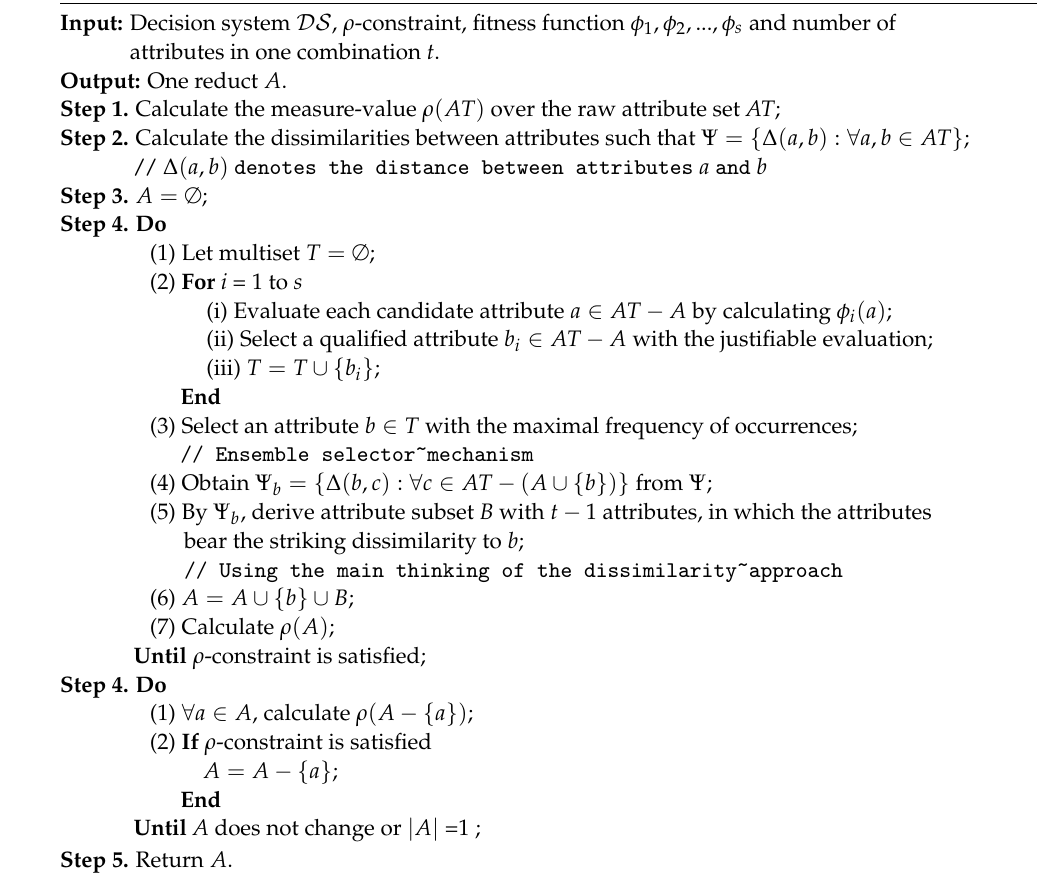
Algorithm 4. Hybrid Mechanism for Attribute Reduction